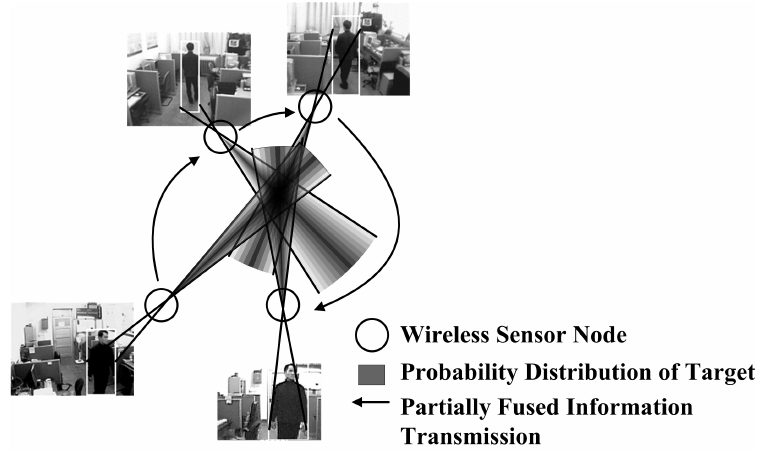
Figure 4. Multi-view localization fuses Gaussian distribution results from different wireless sensor